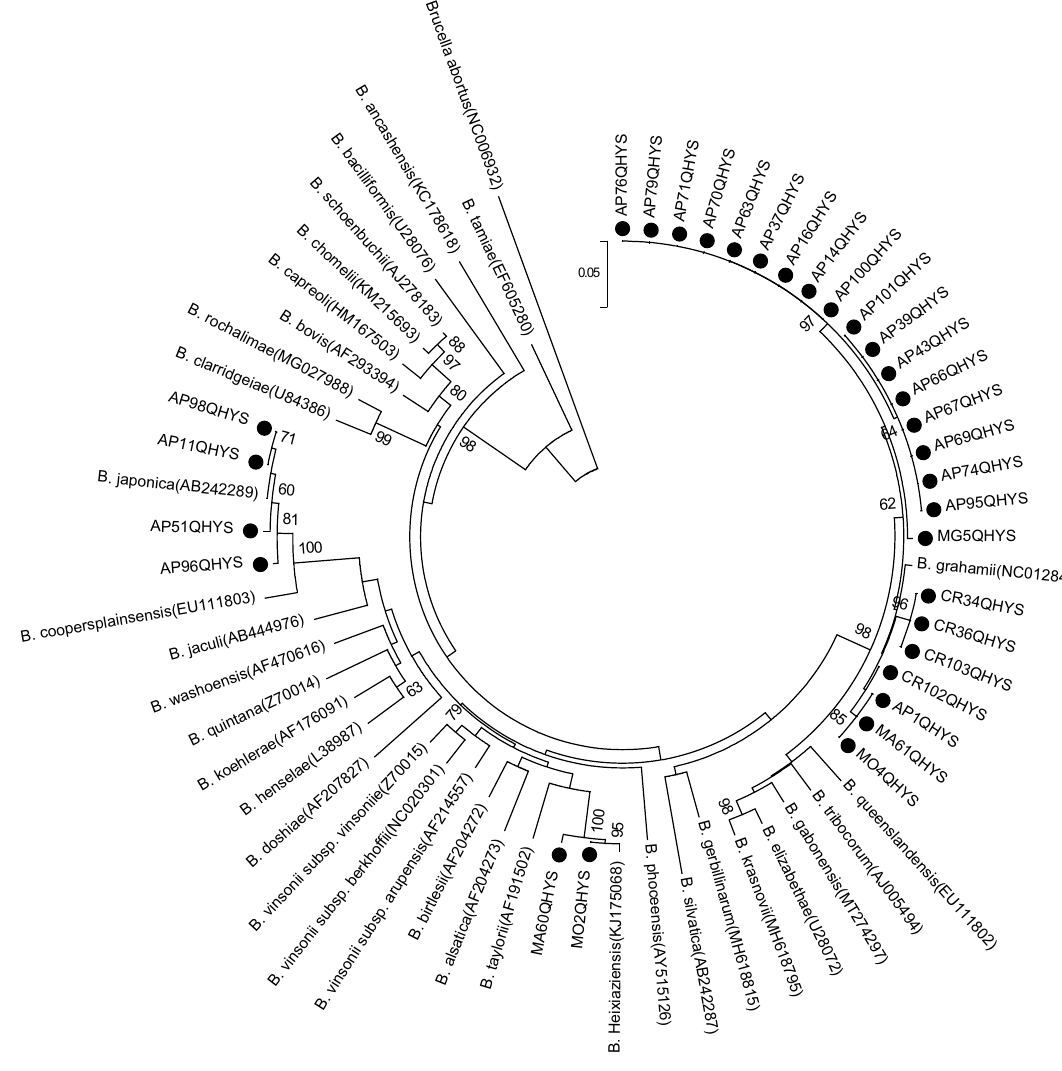
Figure 2. Phylogenetic trees constructed based on gltA gene of 31 Bartonella isolates. The tree was constructed by using the maximum-likelihood (ML) method with the Kimura 2-parameter model, bootstrap values calculated with 1000 replicates in MEGA version 7.0 (https:// www. megas oftwa re. net). The sequences detected in this study are indicated with black dots. Brucella abortus was used as